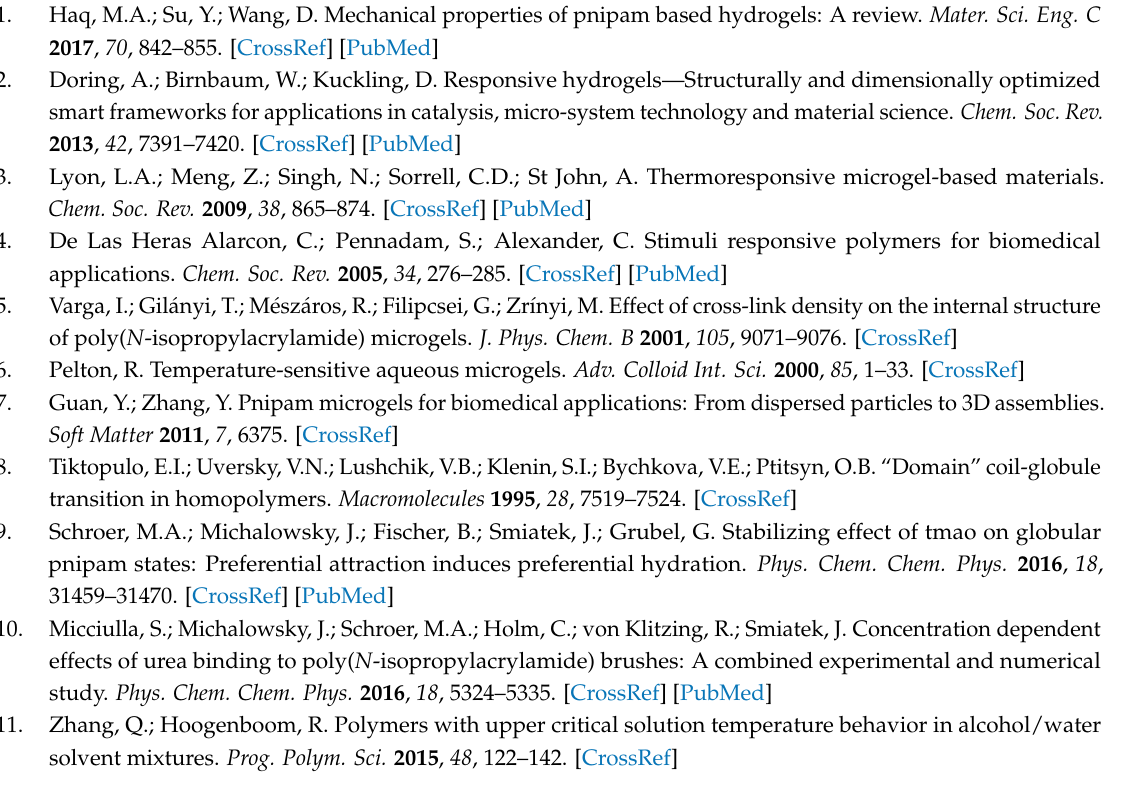
Figure S1: TGA measurements (a) and its derivative (b) of Si-2, SiTPM-2, SiPN-1, SiPN-2 and SiPn3, Table S1: Weight loss of the sample:Si2, SiTPM-2, SiPN-1, SiPN-2 and SiPn3 within the temperature range 25–150 ◦ C (region 1) and within the temperature range 150–500 ◦ C (region 2) and residue at 500 ◦ C. In the first region the weight loss corresponds to the solvent evaporation. In the second region the weight loss corresponds to the thermal decomposition of the organic